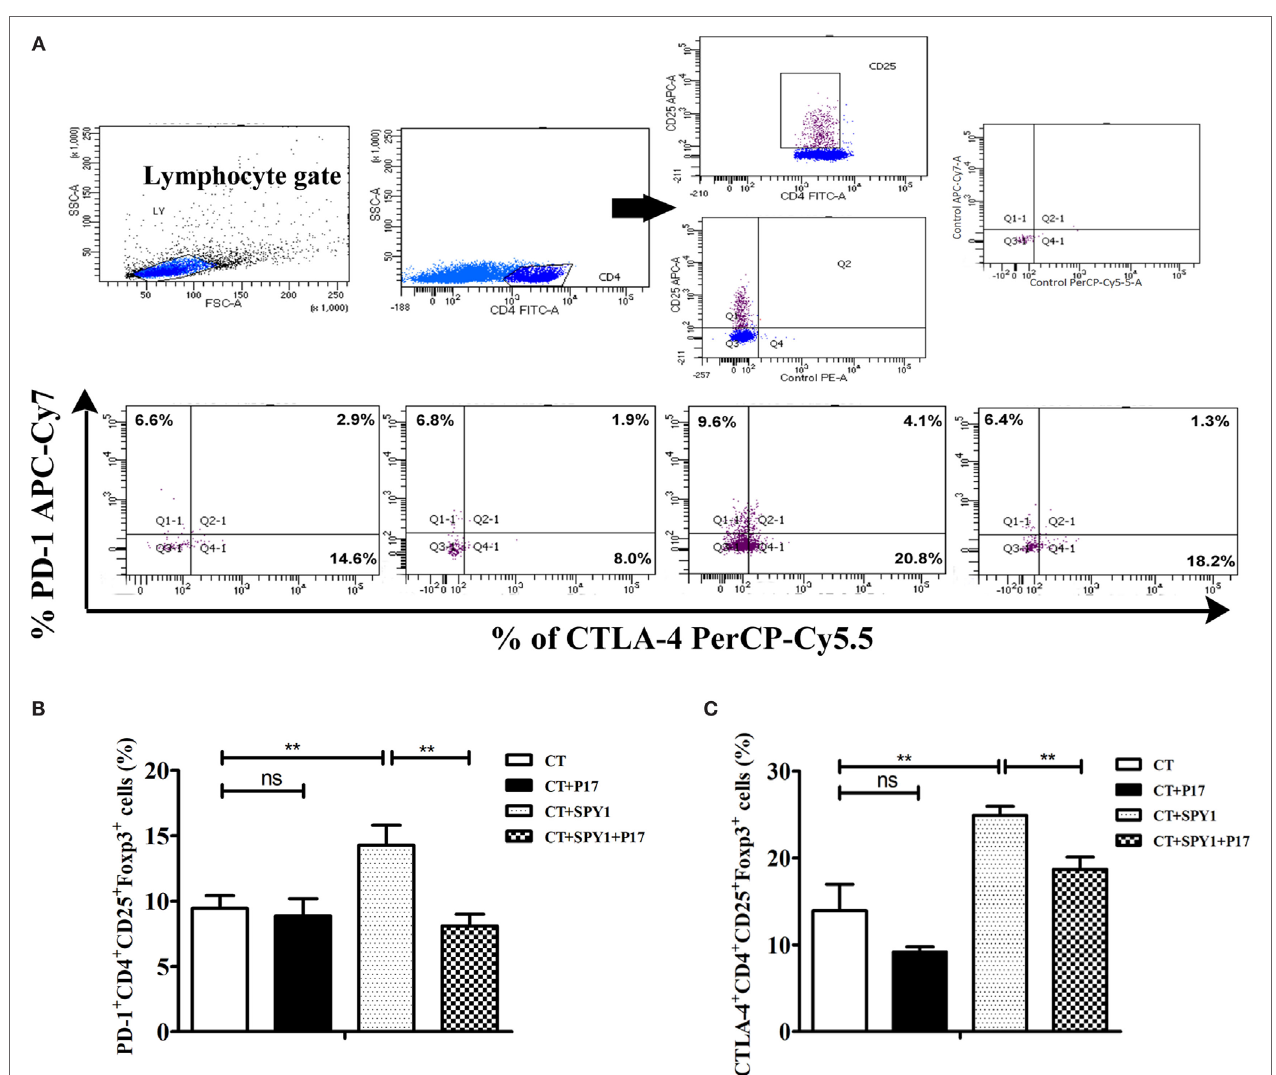
FigUre 7 | SPY1 vaccination stimulates elevating expression of PD-1 and CTLA-4 on regulatory T cells (Tregs) in immune mice. (a) Mice were intranasal challenged with pneumococcal strain 19F on day 7 after the last immunization, and mice lungs were removed on day 3 post-infection. The relative expression of PD-1 and CTLA-4 on CD4 + CD25 + Foxp3 + cells were analyzed by flow cytometry with antibodies including anti-mouse CD279(PD-1)-APC/Cy7, anti-mouse CD152(CTLA-4)- PerCP/Cy5.5, anti-mouse CD4-FITC, anti-mouse CD25-APC, and anti-mouse Foxp3-PE, respectively. The procedure was as describe in Section “Materials and Methods.” Percentages of PD-1 + CD4 + CD25 + Foxp3 + cells (B) and CTLA-4 + CD4 + CD25 + Foxp3 + cells (c) in mice lung of triplicate samples were calculated. Data were shown as the mean ± SD. ** p <